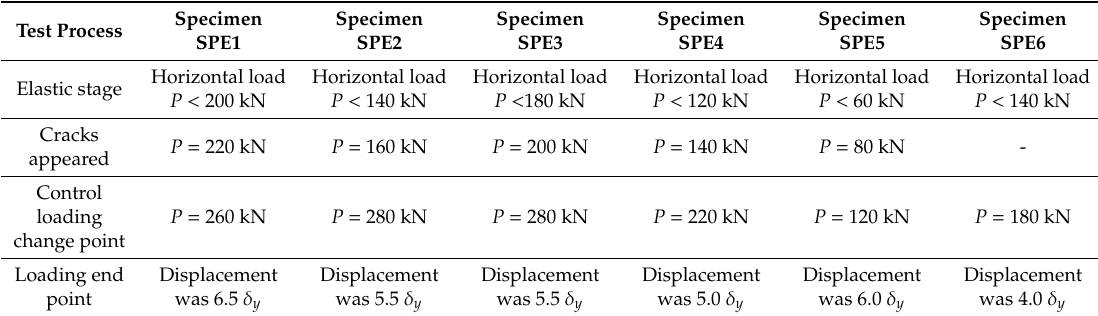
Table 3. Several key load points in the test